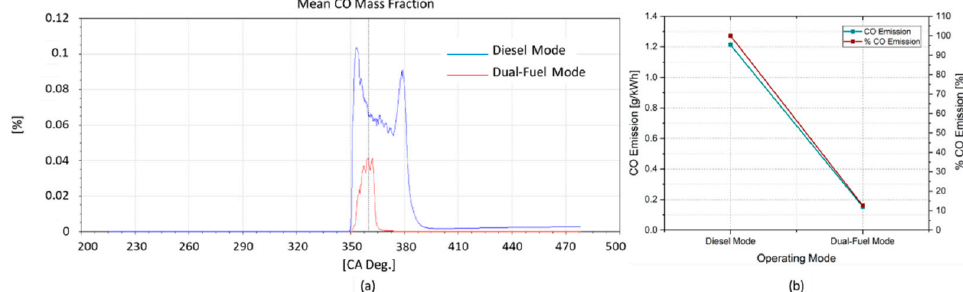
Figure 16. The mean CO mass fractions ( a ) and CO emission masses ( b ) in both combustion cases.